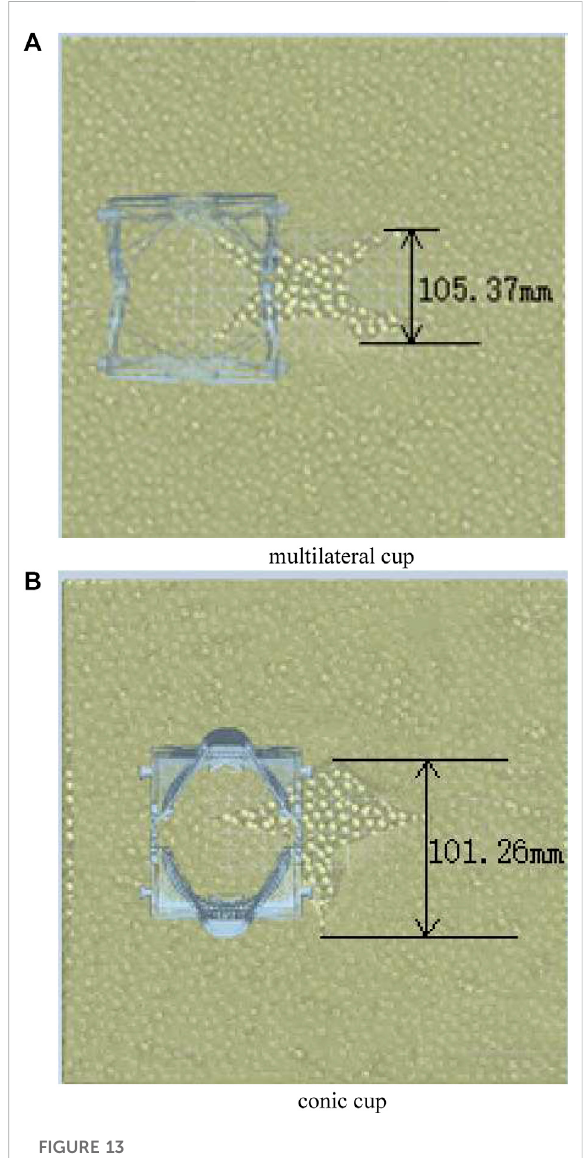
FIGURE 13 The effect of tearing plastic fi lm by hanging